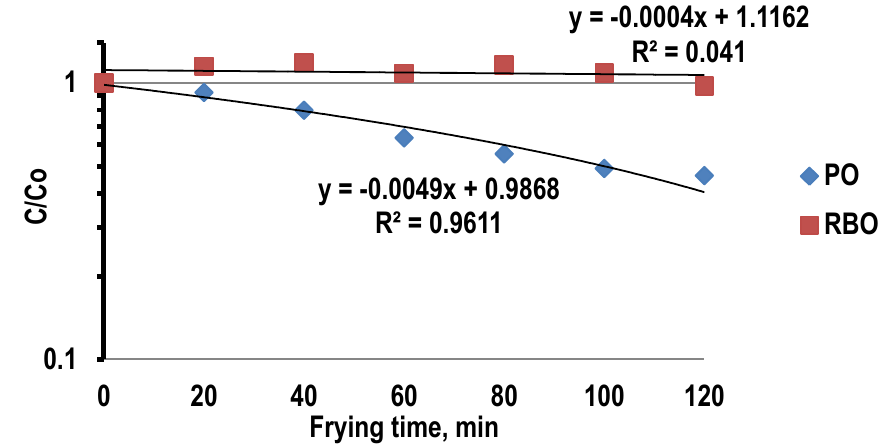
Figure 5. First order kinetic plots of the degradation of α-tocopherol in palm oil and rice bran oil during deep-frying.